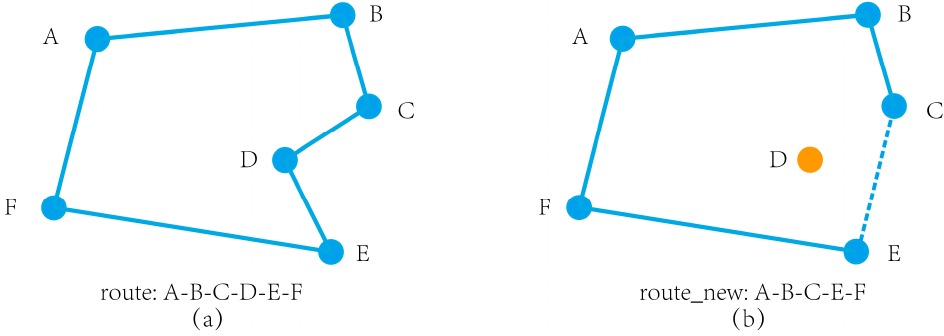
Figure 5. Practical instance of occupy operator: ( a ) static route; ( b ) new route by occupy operator.